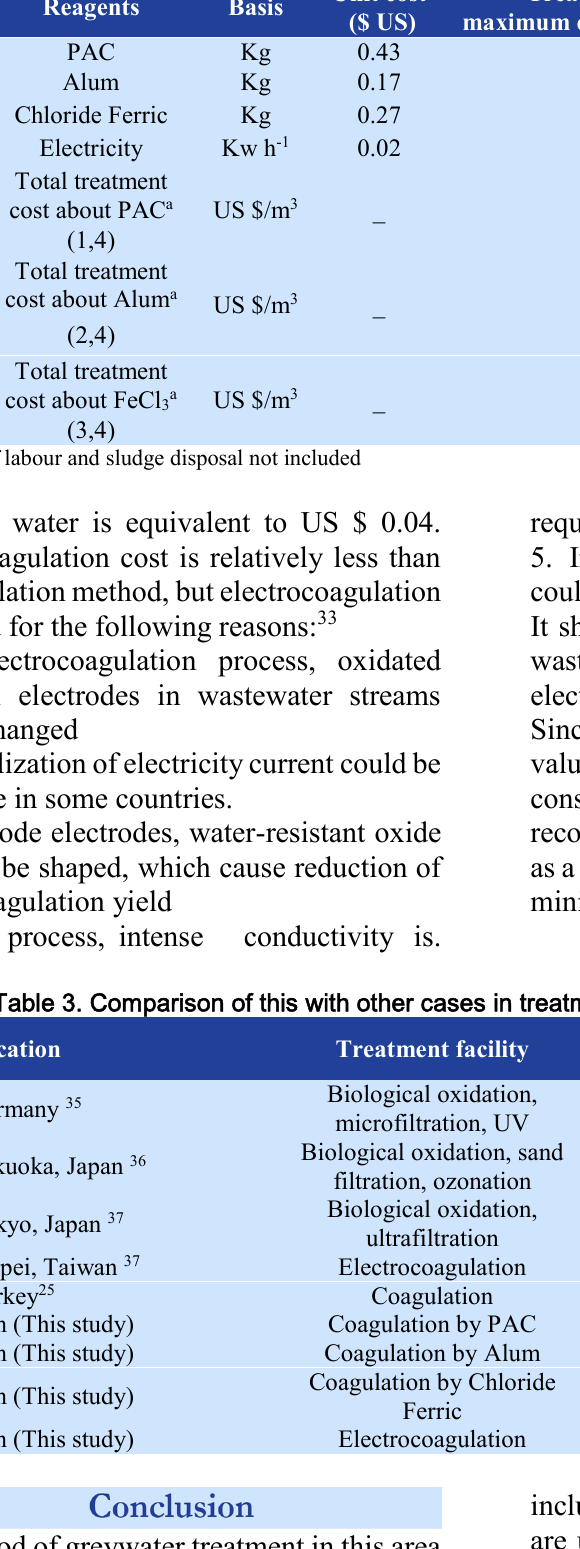
Treatment cost for